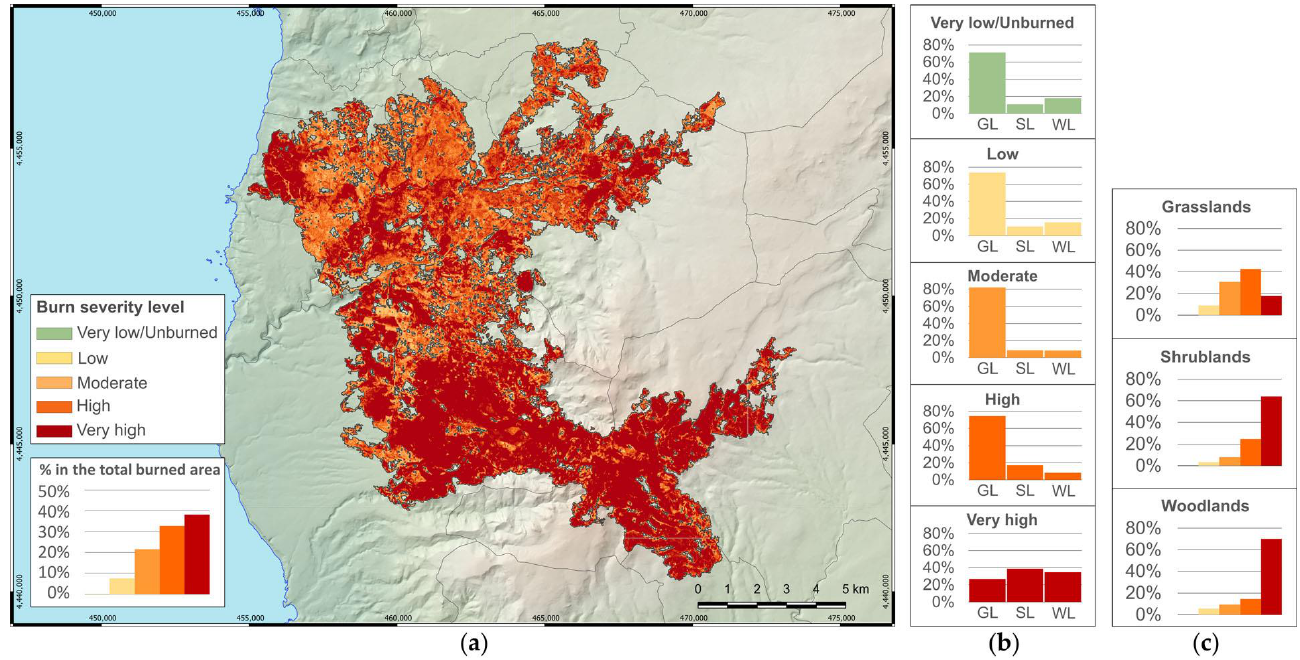
Figure 2. Post-fire burn severity (dNBR pre-post ) in the study area. ( a ) Map of burn severity levels. The histogram in the map shows the percentage distribution of severity levels in the total burned area. The reference system is WGS84–UTM. ( b ) Percentage distribution of severity levels among grasslands (GL), shrublands (SL), and woodlands (WL). ( c ) Percentage distribution of severity levels within the vegetation types.